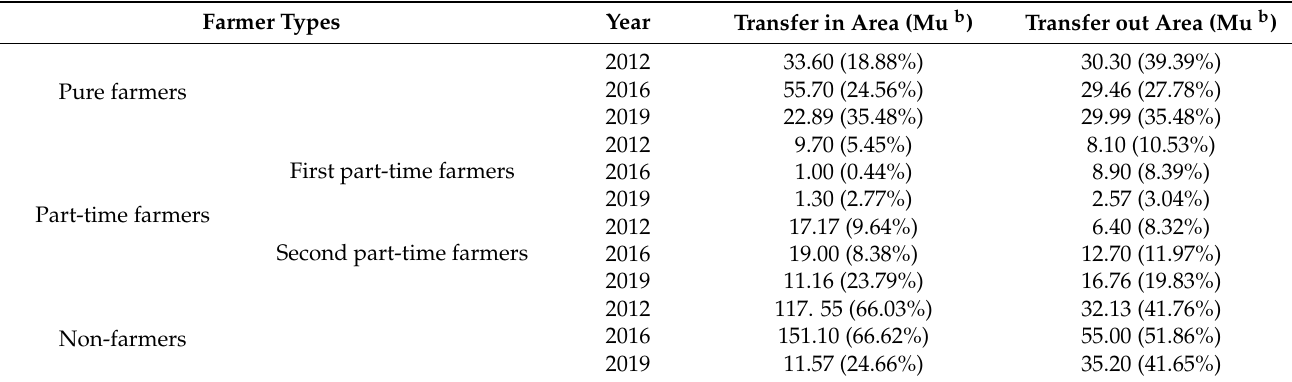
Table 4. Farmers’ total land transfer area a c ( n =